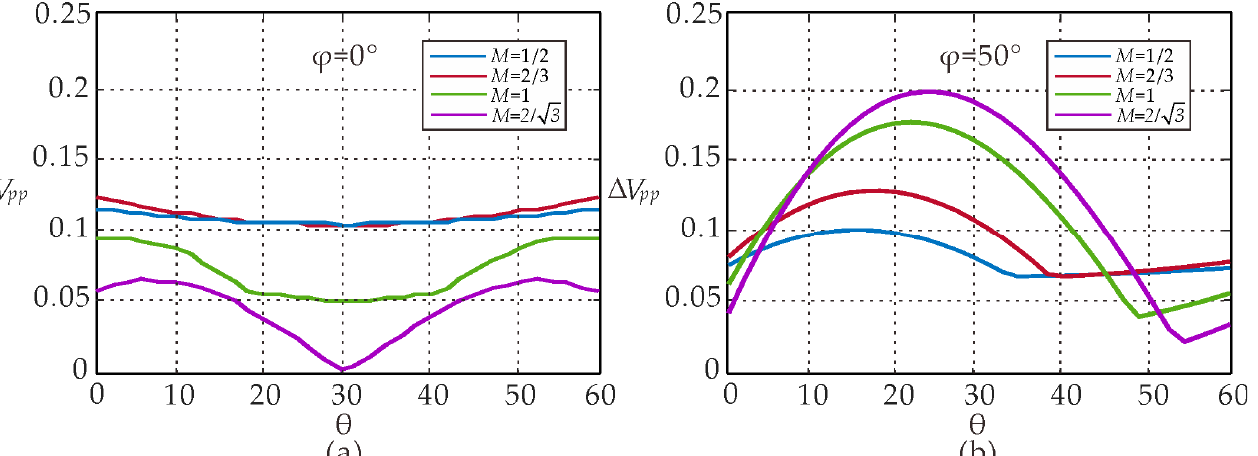
√ 3, and output phase angles ( a ) ϕ = 0 ◦ and